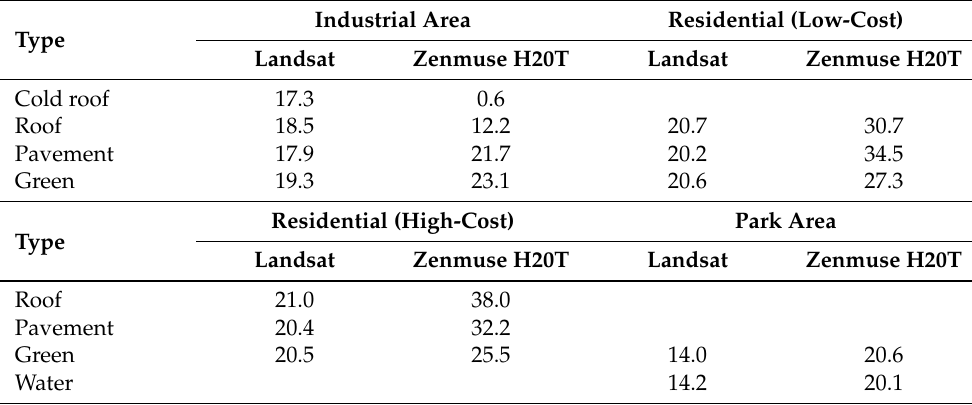
Figure 9. LST comparison between Zenmuse H20T and Landsat on 2/3 October and 19 October. ( a ) LST obtained from Zenmuse H20T on 2 October and Landsat on 3 October ( b ) LST obtained from Zenmuse H20T and Landsat 8-9 on 19 October. Table 8. Mean LST ( ◦ C) of land types on 19